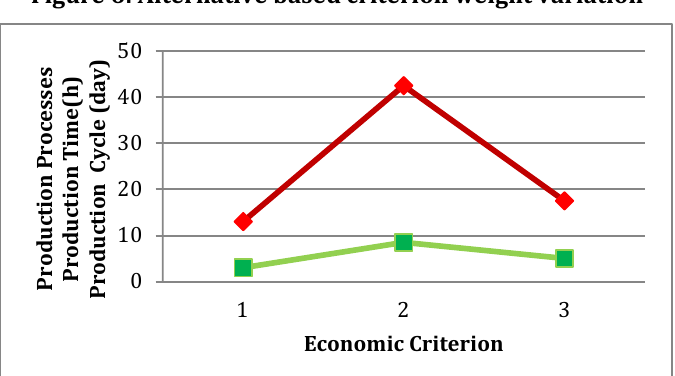
Figure 6: Alternative based criterion weight